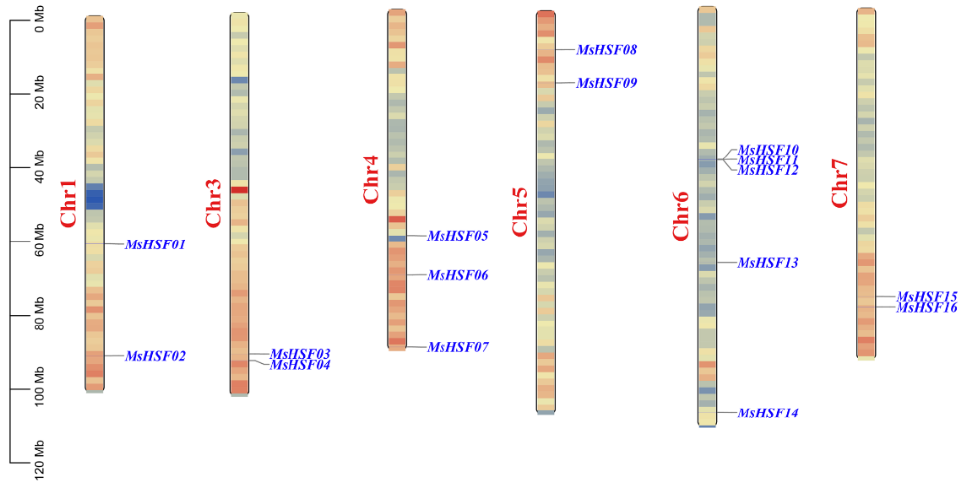
Figure 5. Distribution of MsHSF genes on the chromosomal scaffolds of M. sativa .